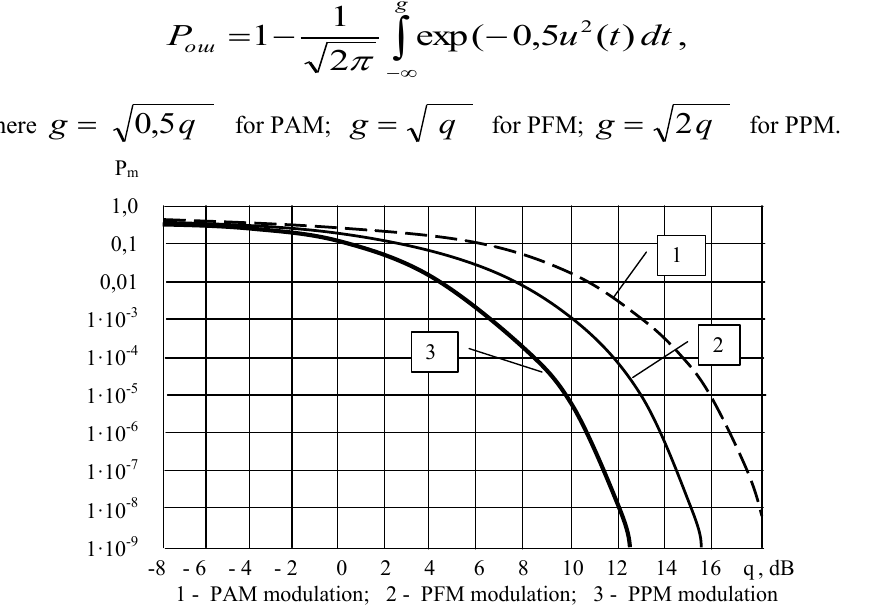
Fig. 6. The dependence of the error probability P in the reception of a single character on the ratio of the signal power to the noise power q for modulation type PAM, PFM и